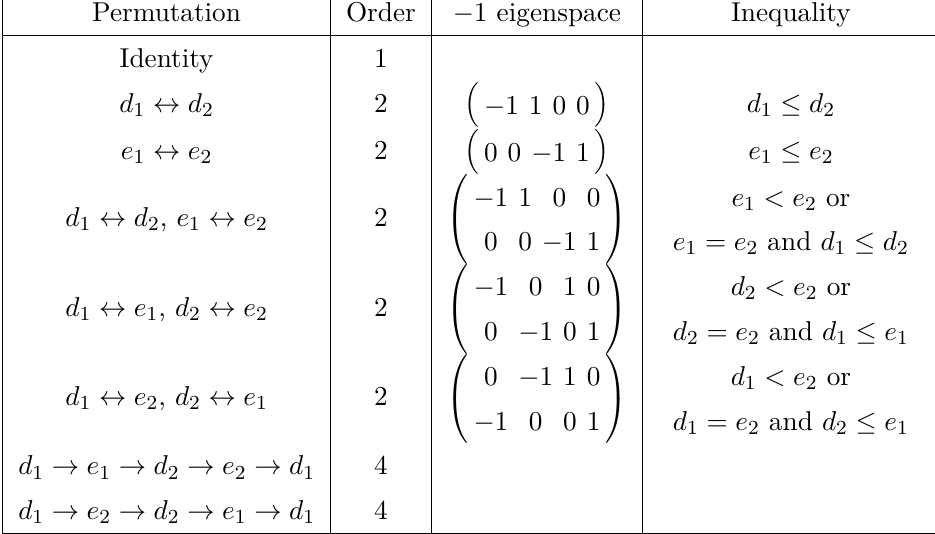
Table 6 . Elements of the group Dih 4 . In the first column, they are presented as permutations, acting on ( d 1 , d 2 , e 1 , e 2 ) . The second column is the order of the element, the third gives a basis of the − 1 eigenspace in the ( d 1 , d 2 , e 1 , e 2 ) representation. The last column displays the condition imposed by